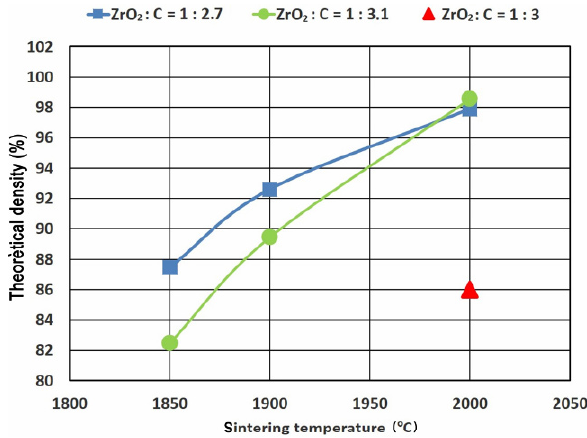
Fig. 8 Densification of ZrC material with different stoichiometry.